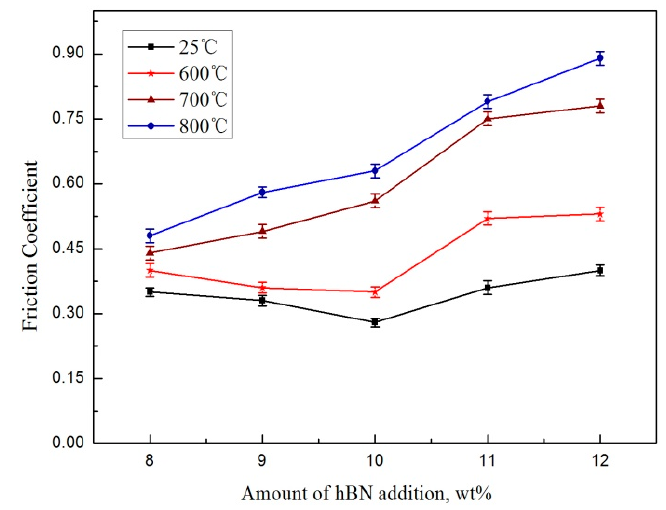
Figure 5. Influence of hBN content on the friction coefficient of NiCr/hBN composite at different friction temperatures.